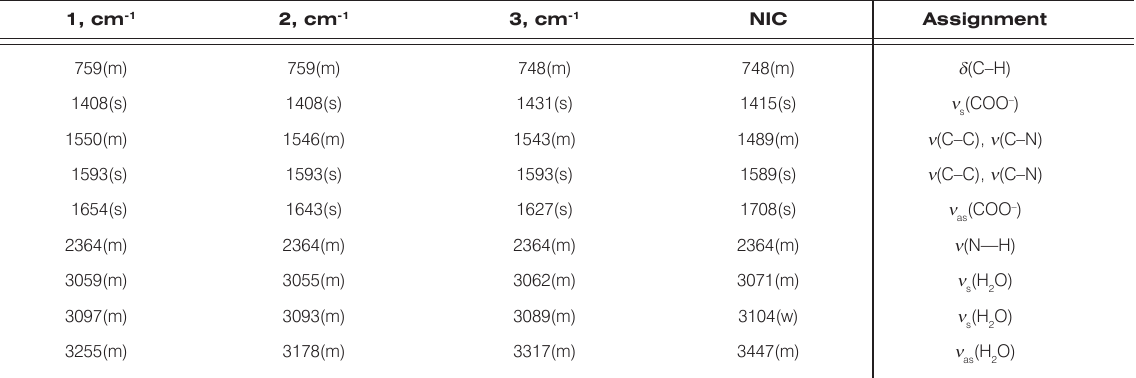
Table 4. Values of some bands in the IR absorption spectrum of compounds, 1 , 2 , 3 and the ligand nicotinic acid (NIC).